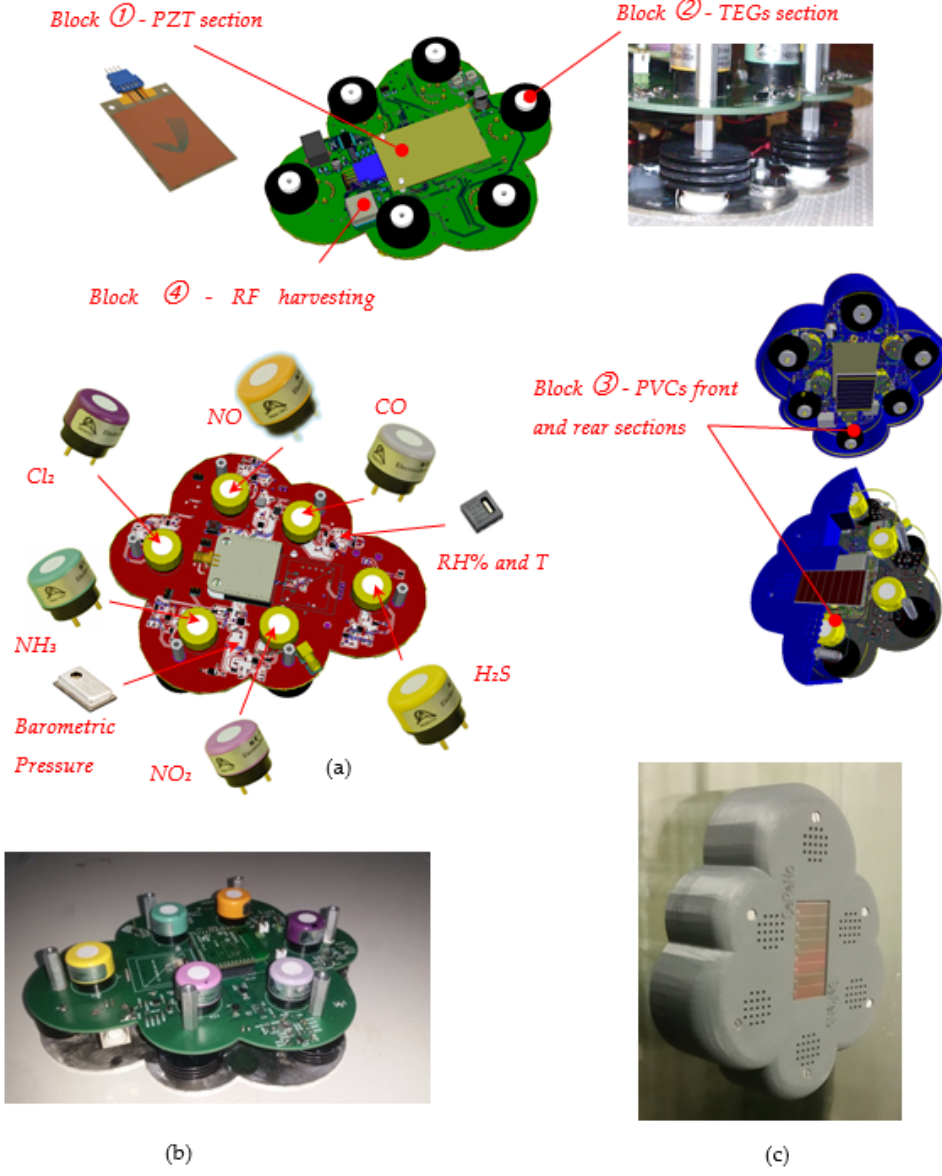
Figure 1. ( a ) Power harvesting and sensing blocks; ( b ) example of SERENO prototype; ( c ) SERENO sensing node applied onto a window.